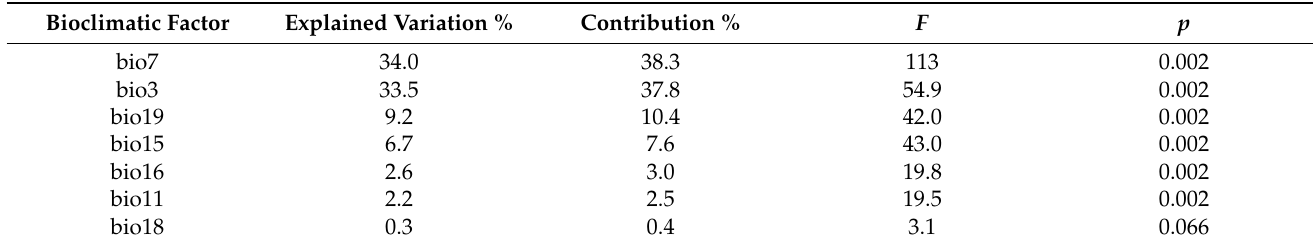
Figure 2. Ordination of geographical distribution and bioclimatic factors of venerable trees in Sichuan using redundancy analysis (RDA). See Table S1 for the meaning of bioclimatic factors. The solid arrowhead indicates the longitude and latitude as the dependent variable, and the hollow arrowhead indicates the bioclimatic factor as the independent variable. The included angle indicates the correlation (acute angle for positive correlation, obtuse angle for negative correlation, and right angle for no correlation). Table 1. Monte-Carlo test results of geographical distribution and bioclimatic factors of venerable trees in Sichuan, ranked by their